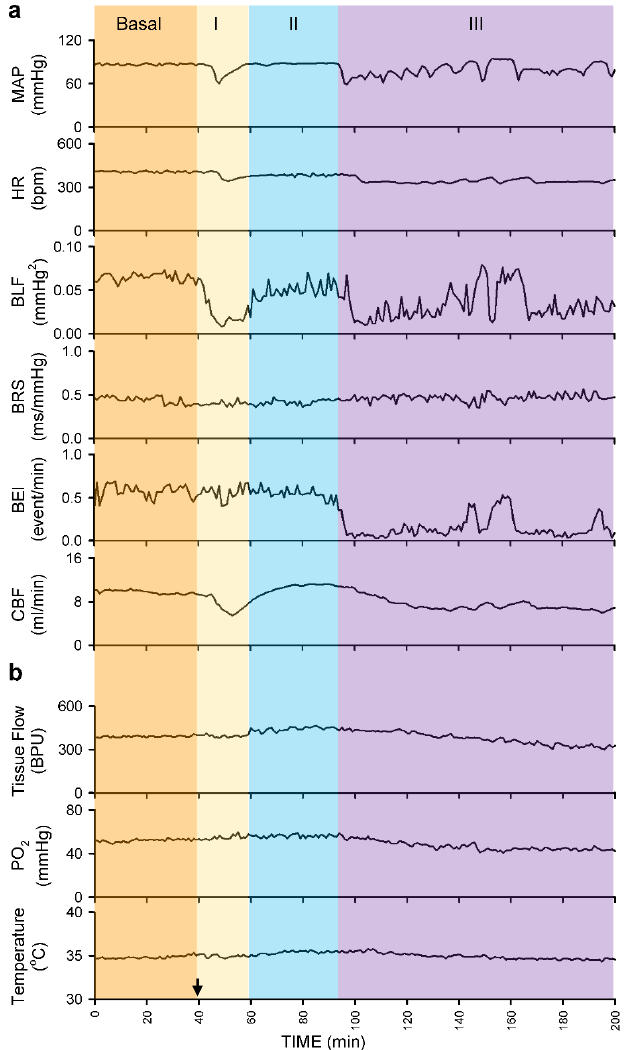
Figure 7. Illustrative examples of real-time and online recording of anomalous phasic changes in MAP, HR, BLF, BRS or BEI, simultaneous with CBF in Group 2 animals ( a ); or concurrent with tissue perfusion, PO 2 or temperature in the cerebral cortex in Group 3 animals ( b ) with intrathecal administration of 80 μL of bupivacaine (at arrow).